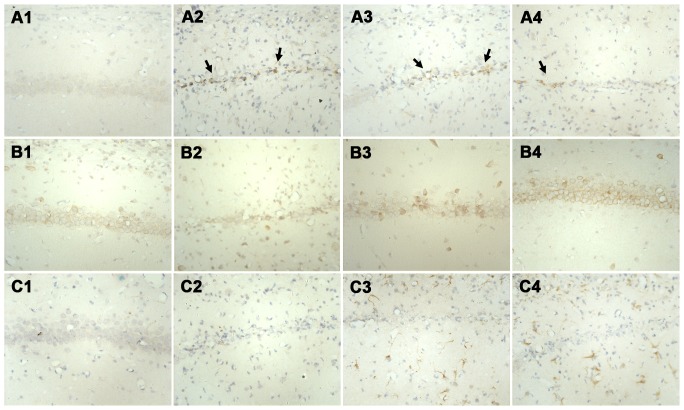
Immunohistochemical staining of the CA1 region of the hippocampus (×400).
A, B, and C, staining for Aβ1–42, IDE, and PPARγ, respectively. 1, 2, 3, and 4: control, untreated, Rg1+GW9662, and Rg1 groups, respectively. Control group, intrahippocampal injection of normal saline and intraperitoneal injection of normal saline; Untreated group, intrahippocampal injection of Aβ1–42 and intraperitoneal injection of normal saline; Rg1+GW9662 group, intrahippocampal injection of Aβ1–42 and intraperitoneal injection of Rg1 and GW9662; Rg1 group, intrahippocampal injection of Aβ1–42 and intraperitoneal injection of Rg1. Arrows indicate exogenous Aβ1–42.